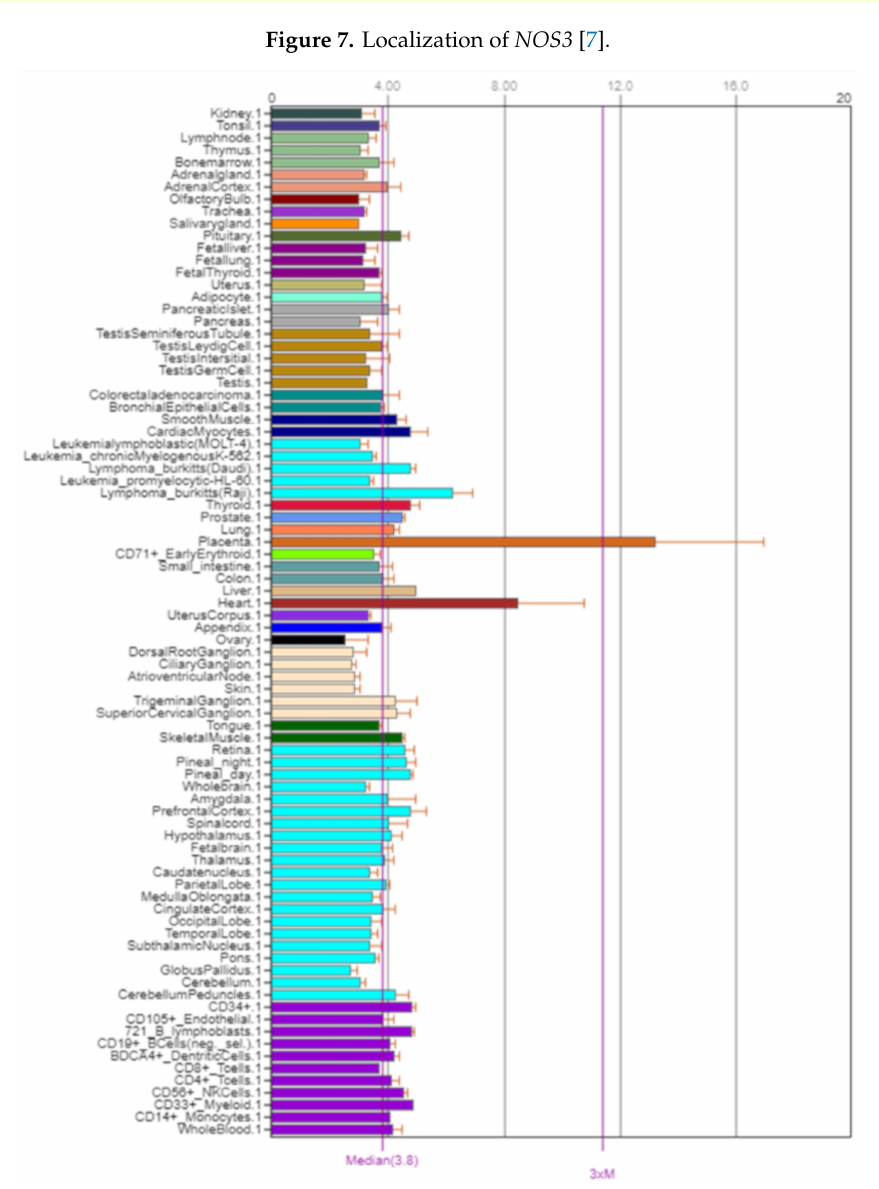
Figure 8. Expression of NOS3 in the human body